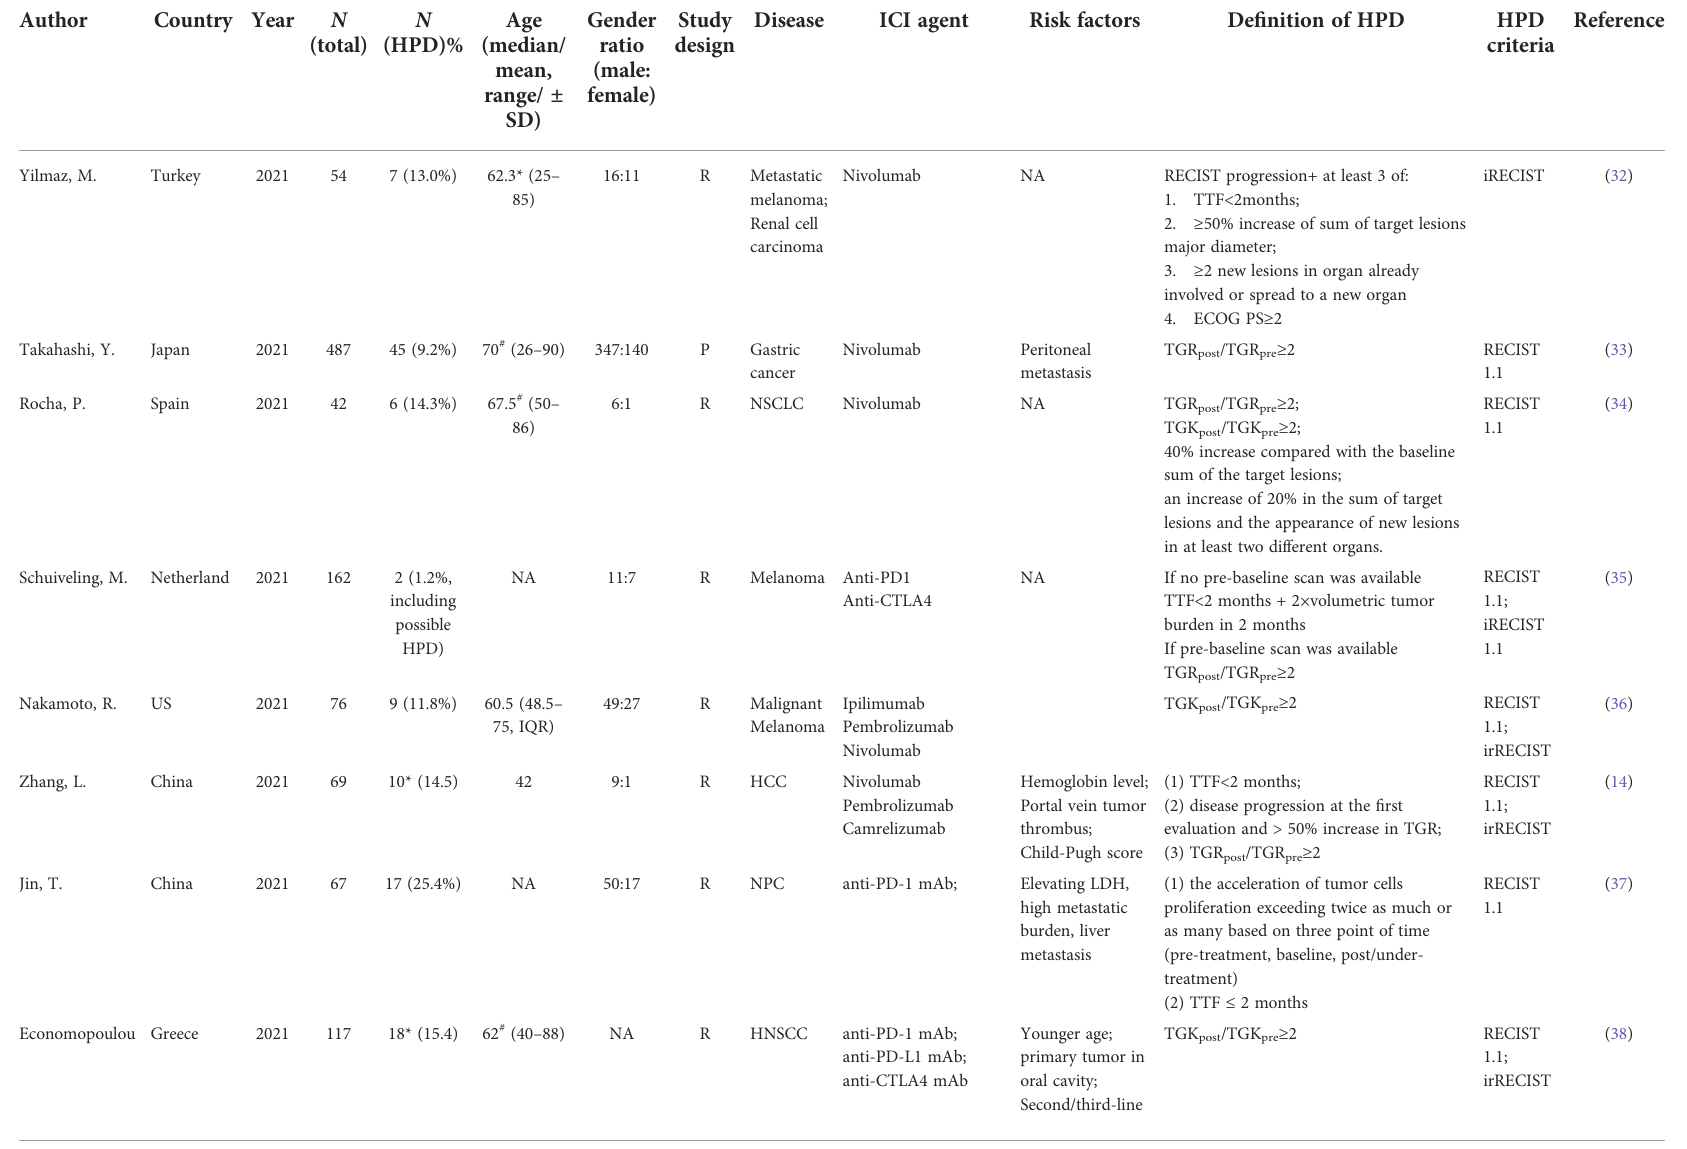
TABLE 2 Characteristics of fi nally included studies and patients. Author Study